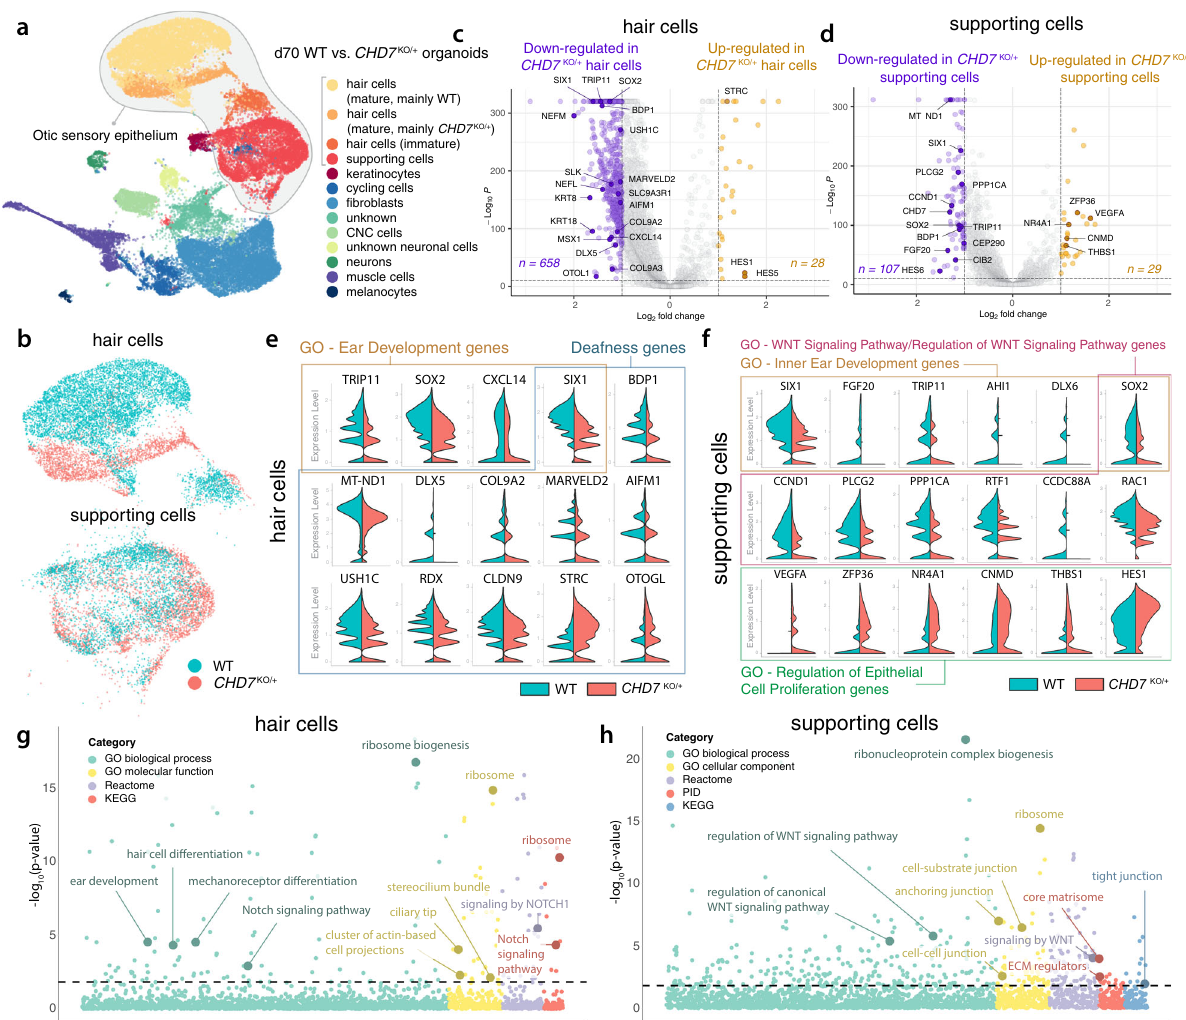
Fig. 6 | scRNA-seq of d70 WT and CHD7 KO/+ organoids revealed the importance of CHD7 in sensory epithelium development. a , b d70 WT and CHD7 KO/+ orga- noidsweremicro-dissectedandFACS-isolatedinto POU4F3 nT -positiveand-negative populations. UMAP plot and cluster annotation of merged datasets of these four groups of cells were shown in ( a ), and UMAP plots of the hair cell and supporting cellsubsetswereshownin( b ).Datarepresent34,703totalcells( a ),9884haircells, and6273supportingcells( b ). c , d Volcanoplotsofdifferentiallyexpressedgenesin